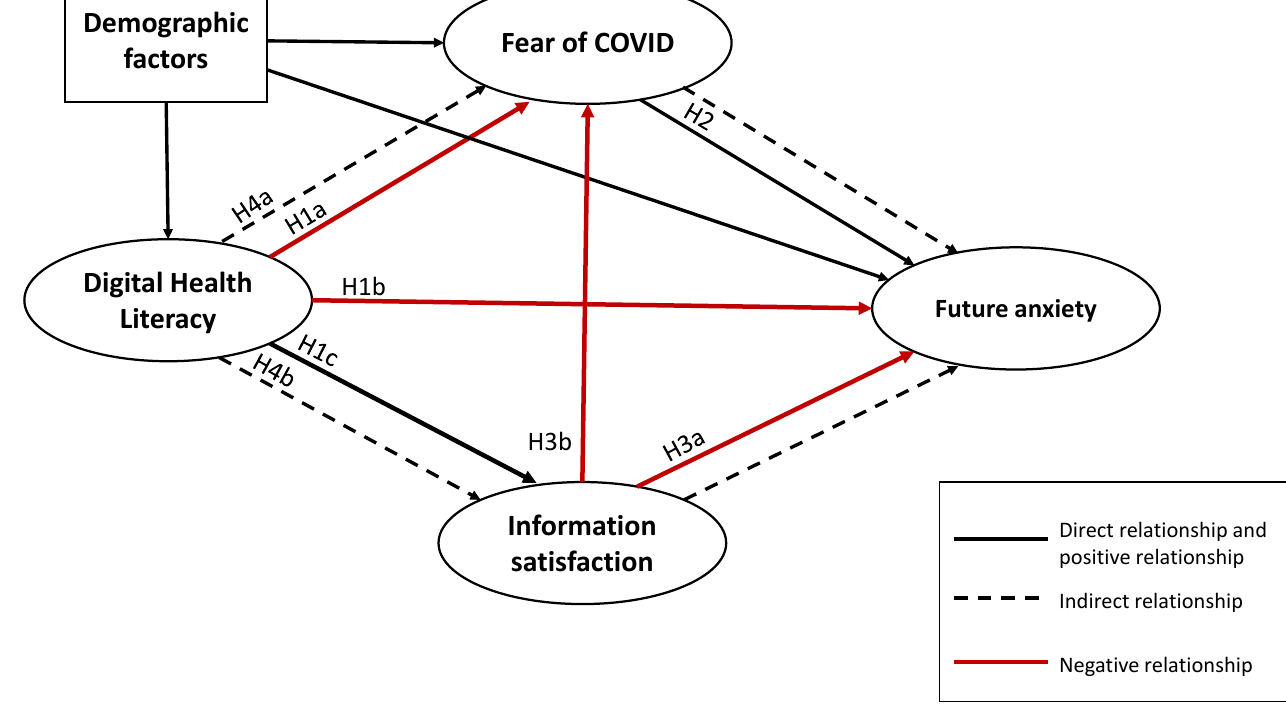
Figure 1. The conceptual